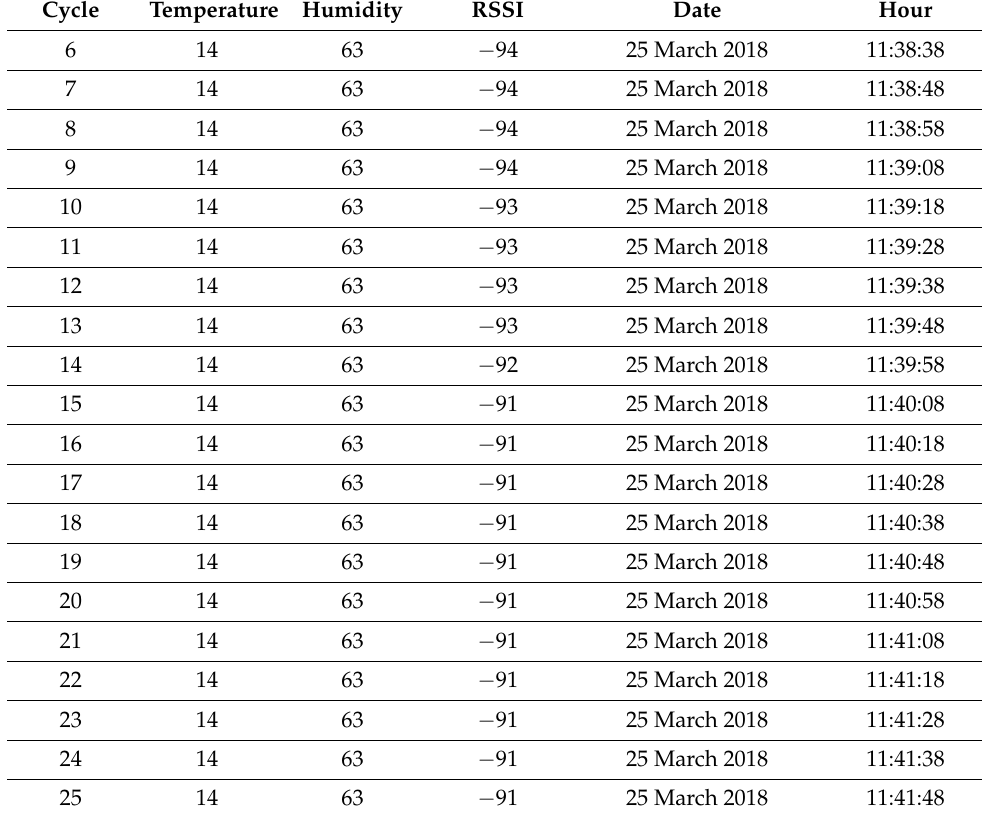
Table 1. Cont. Cycle Temperature